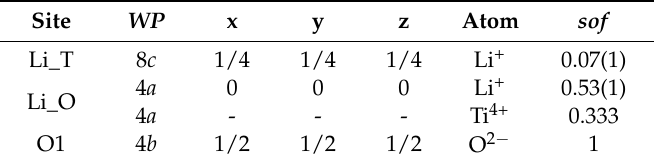
Table 1. Structure model for the Rietveld refinement of α -Li 2 TiO 3 with a mixed Li occupation in octahedral and tetrahedral gaps. Li_T = tetrahedra gap, Li_O = octahedra gap, WP = Wyckoff position, sof = site occupancy